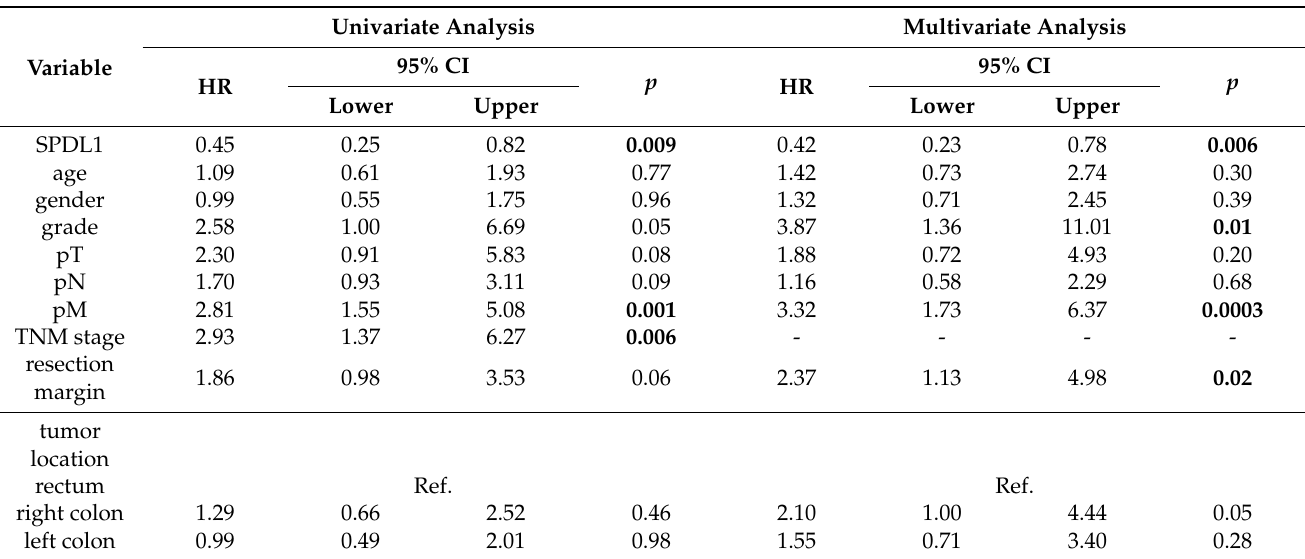
Table 2. Univariate and multivariate Cox regression analyses of OS for CRC patients in our cohort ( n = 75). Univariate Analysis Multivariate